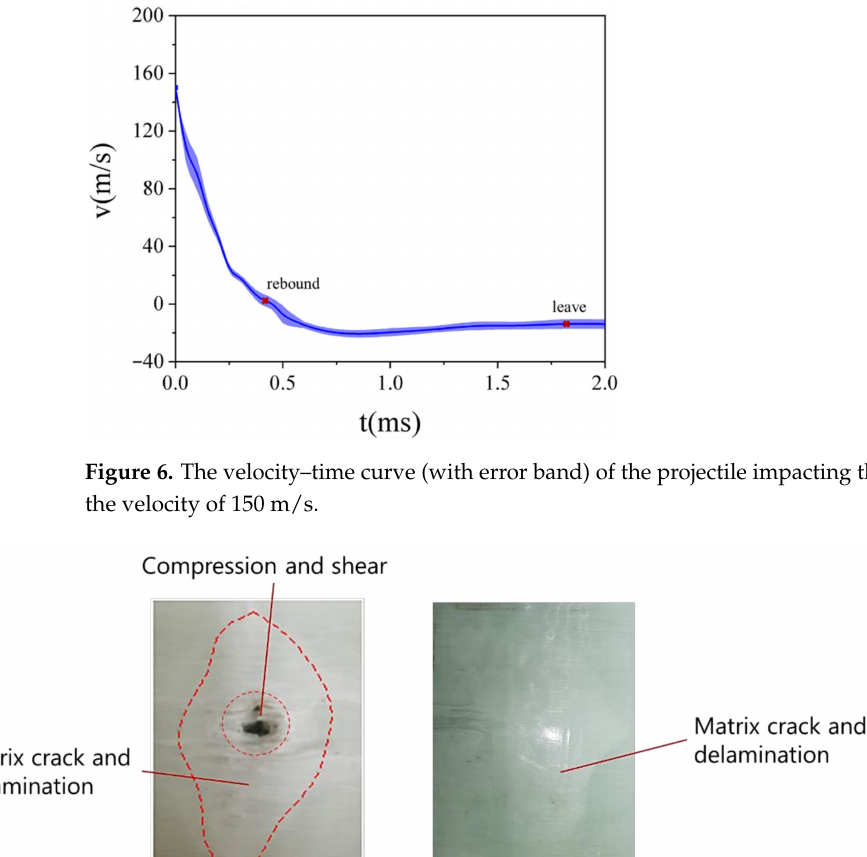
Figure 5. The process of GFRP laminate under the impact of a steel projectile captured by a high-speed camera.